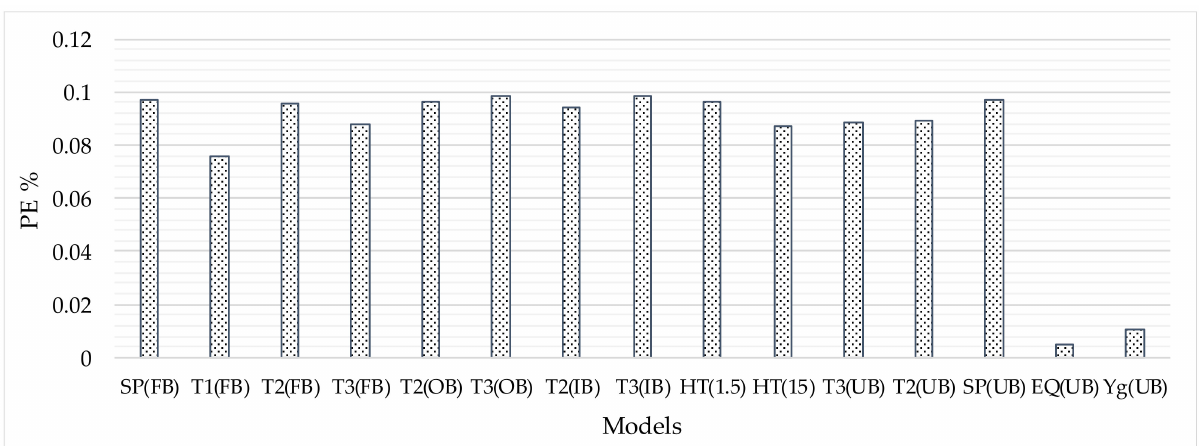
Figure 9. Prediction error (PE in %) of the normalised mean collapse pressure calculated from 95% confidence interval of the